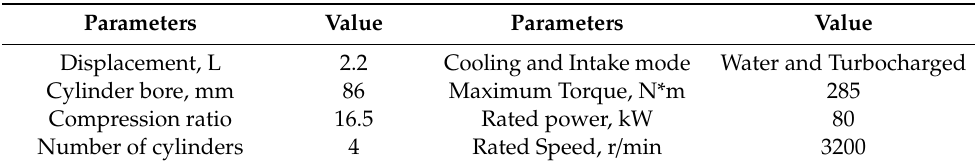
Table 1. Specific engine parameters tested.